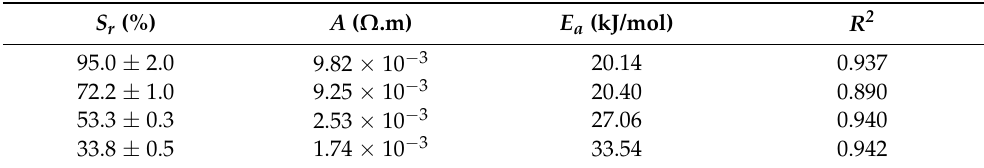
Table 3. Arrhenius law parameters fitted to the transmission configuration resistivity measurements on all specimens for each concrete degree of saturation.